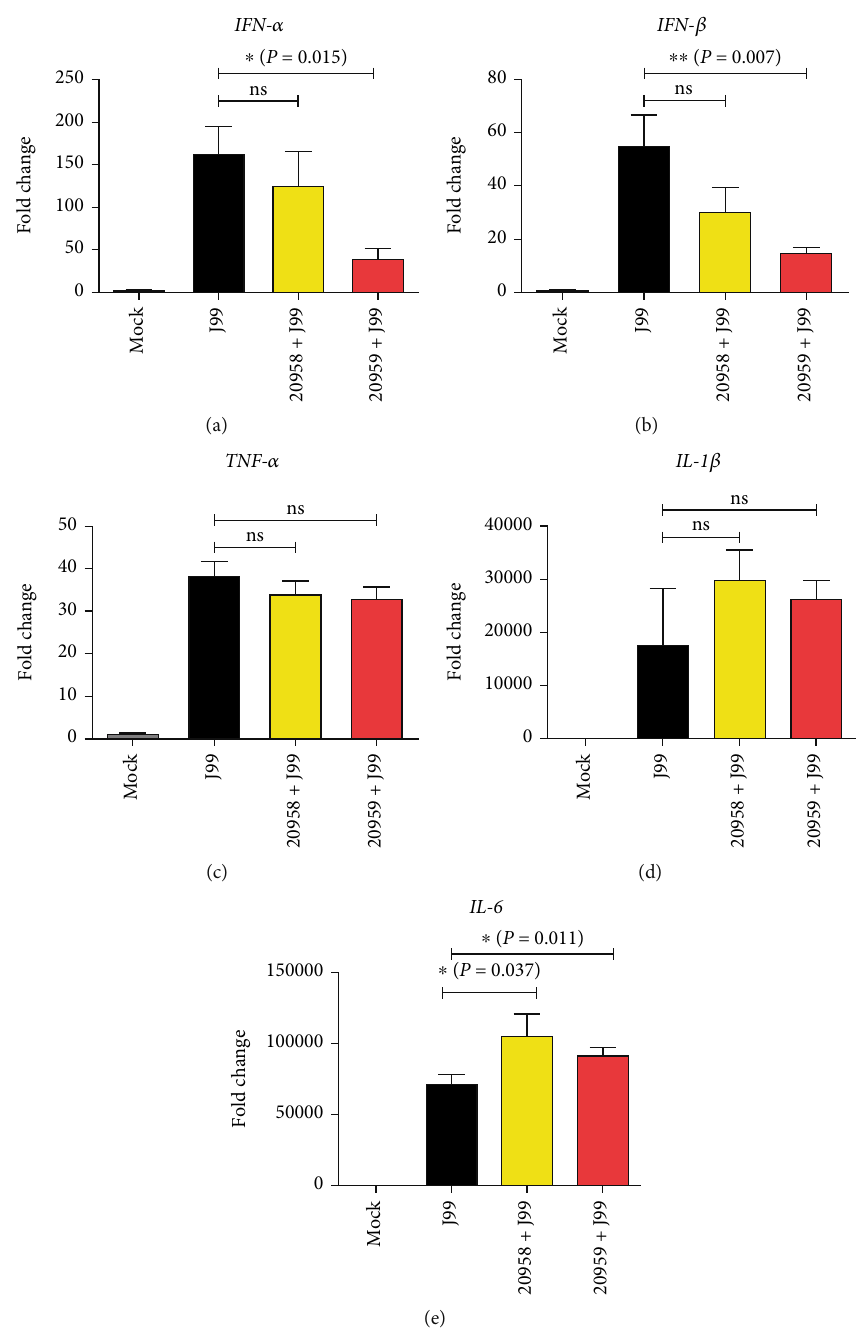
Figure 5: E ff ect of TLR7 and TLR8 antagonists on H. pylori infection-mediated in fl ammatory cytokine expression in THP-1 cells. THP-1 cells were uninfected (mock), infected with H. pylori J99 strain at MOI 10 for 16 hours (J99), or infected and treated with TLR7 inhibitor (ODN20958+ J99) or TLR7/8 inhibitor (ODN20959+J99) for 4 hours prior to infection. Data is presented as mean ± SD from one experiment run in triplicate and is representative of two independent experiments. Statistical signi fi cance was analyzed using Student ’ s t -test ( ∗ P ≤ 0 : 05 ; ∗∗ P ≤ 0 : 01 ; ∗∗∗ P ≤ 0 : 001 ; ns : not signi fi